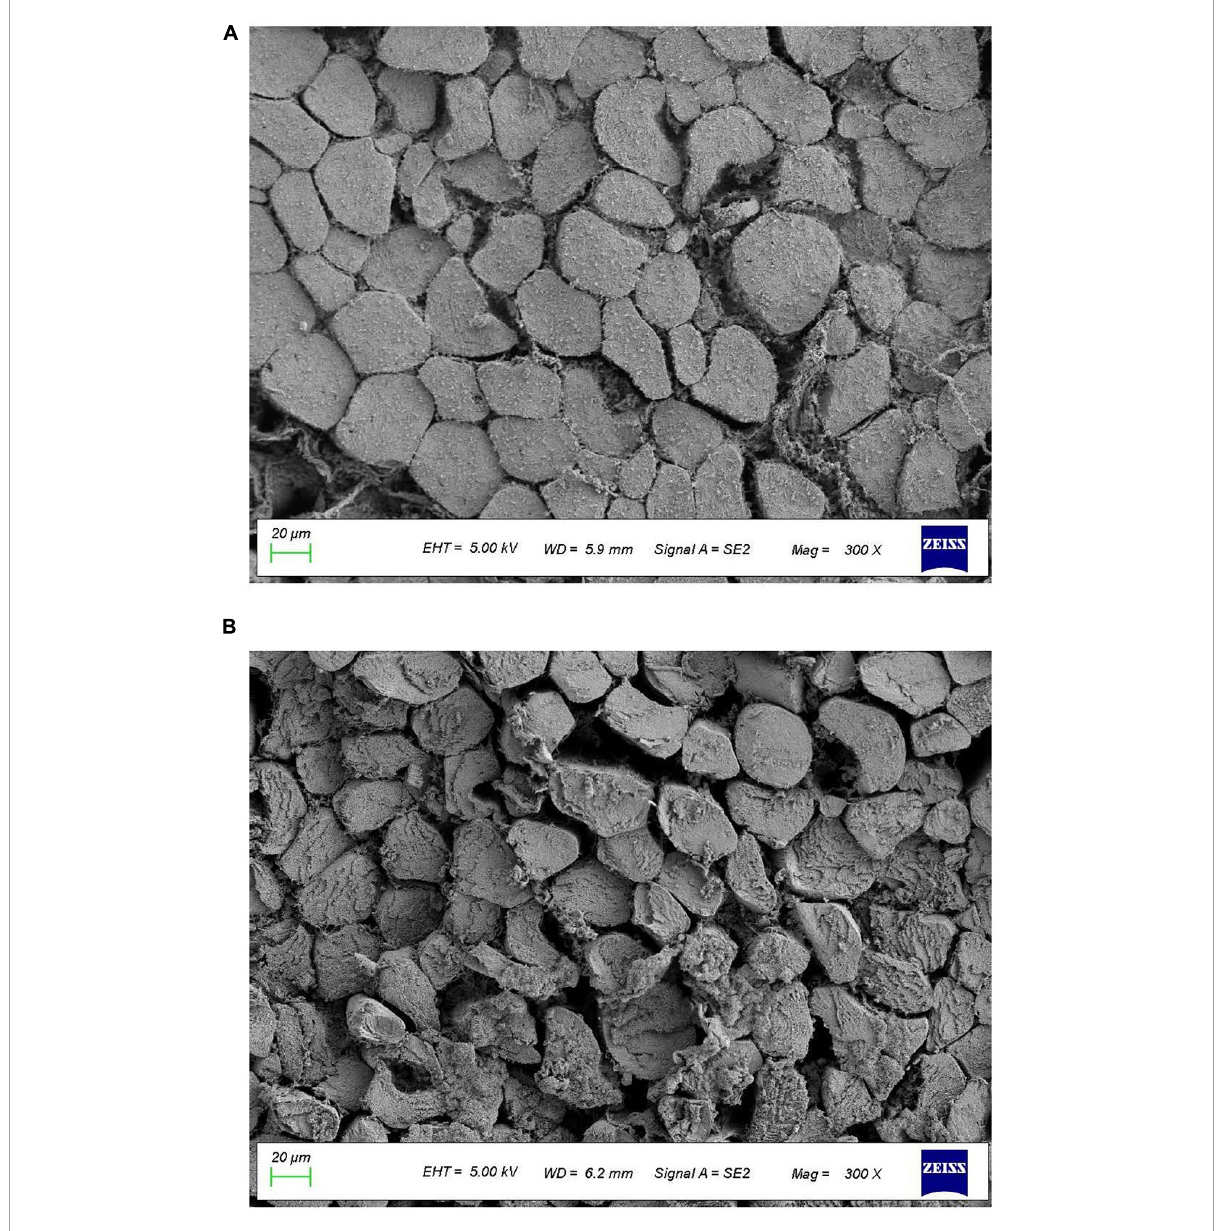
FIGURE2 Effects of vacuum tumbling (A) and immersion marinations (B) on the microstructure of